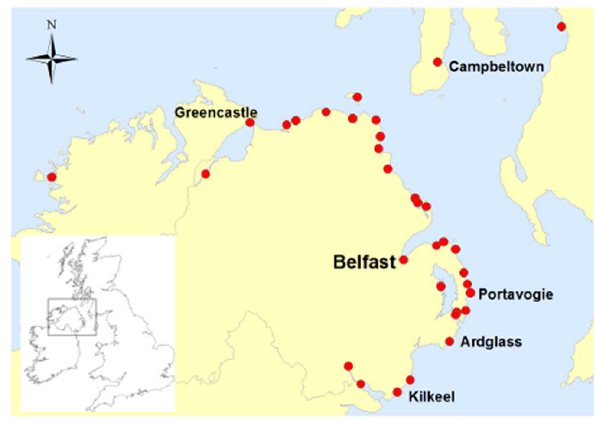
Figure 1. Map of the home ports from which commercially active, Northern Ireland registered vessels fish. Data obtained from the Department of Agriculture and Rural Development, Northern Ireland, 2012.